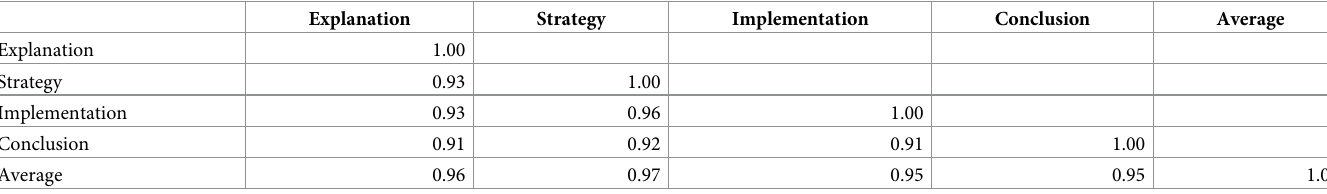
Table 3. Internal consistency of criteria for